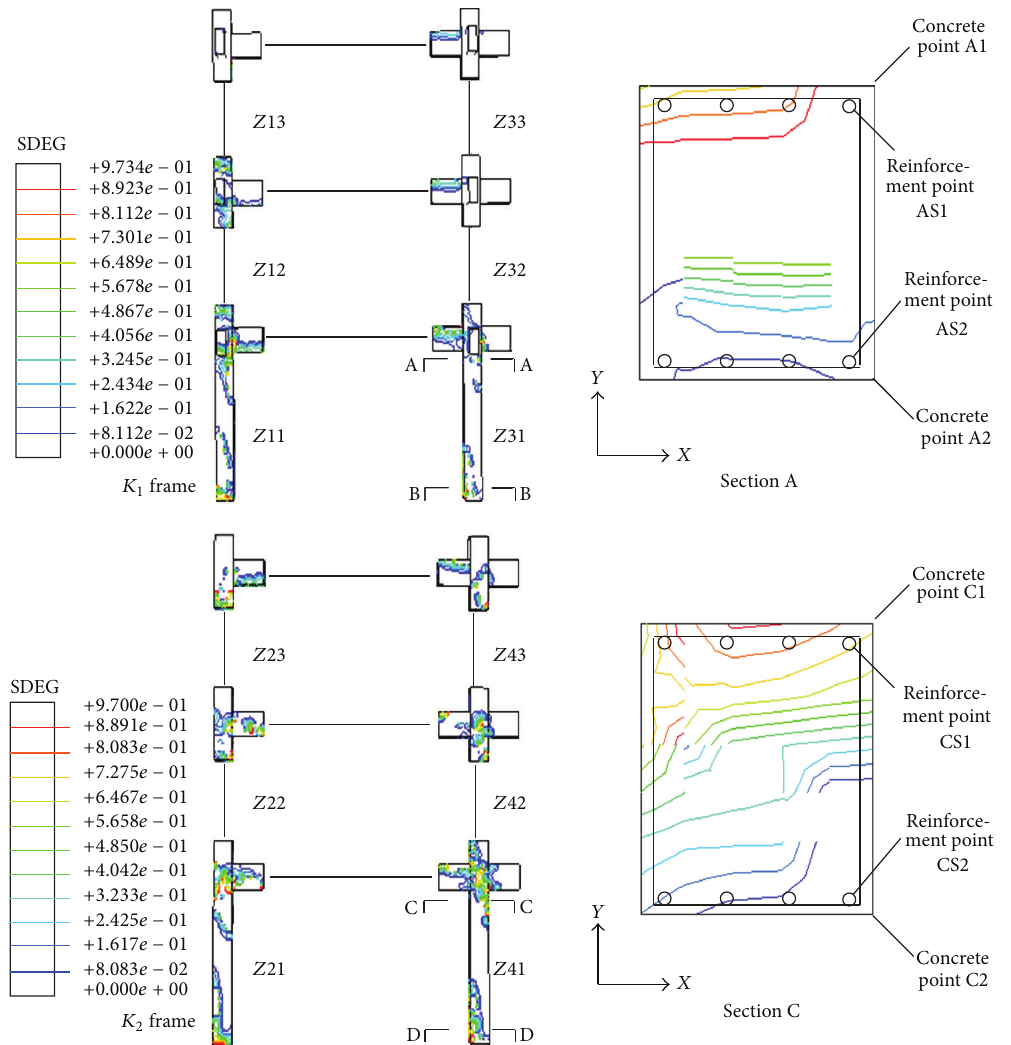
Figure 9: The calculation failure damage states of 𝐾 1 /𝐾 2 frames and test damage